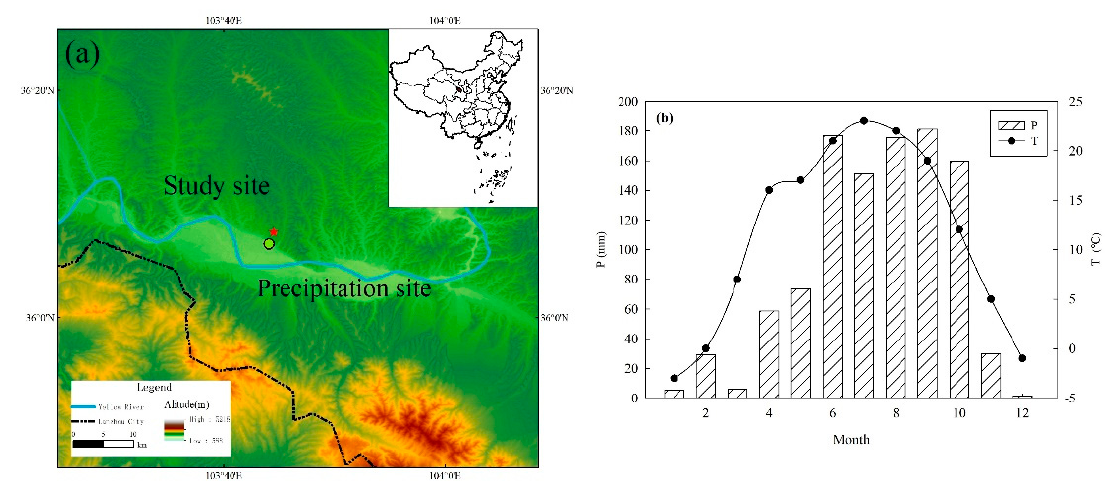
Figure 1. Location of the study area and sampling sites ( a ) of dominant species and the temperature and precipitation in 2019 ( b ) in the Poly Lingxiu mountain.